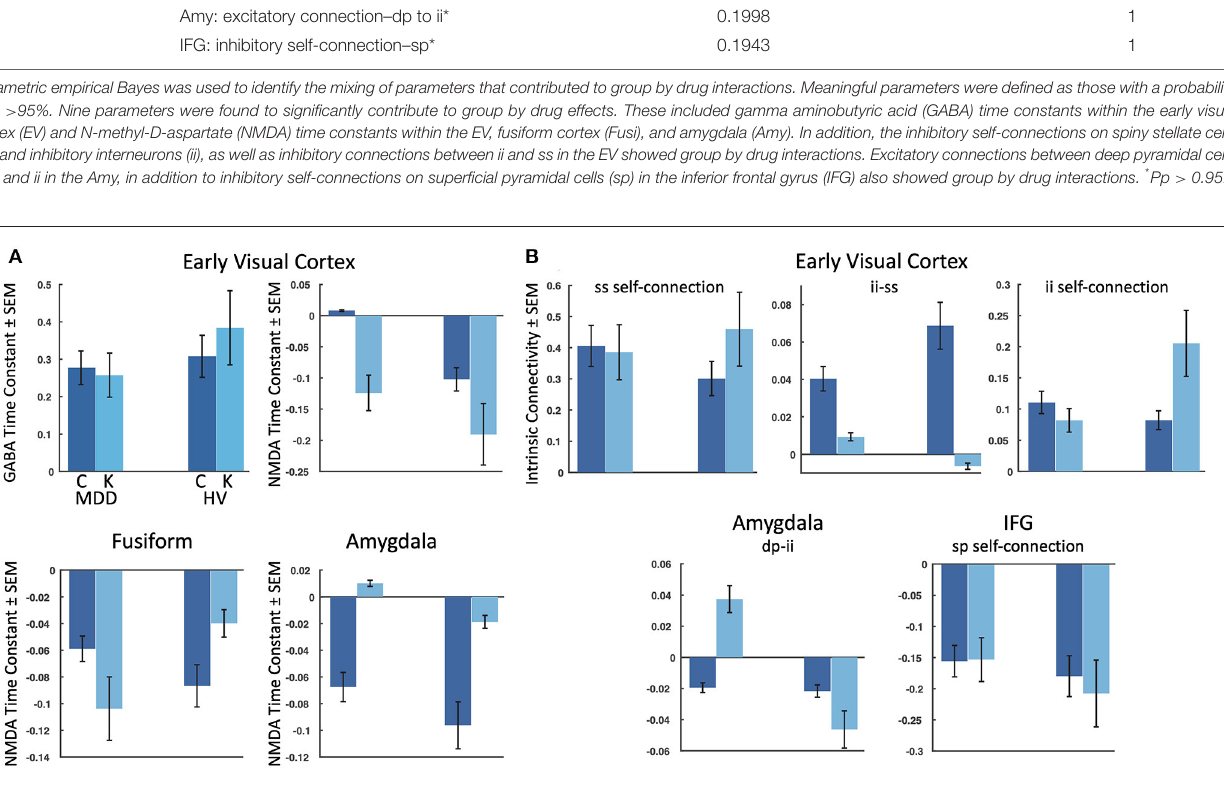
FIGURE 3 | Meaningful parameters showing group by drug interactions. The estimated log mean and variance of each meaningful (95% probability or greater) parameter are plotted for participants with treatment-resistant major depressive disorder (MDD) (left) and healthy volunteers (HV) (right) for: (A) the four receptor time constants showing group by drug interactions, and (B) the five intrinsic connectivity parameters showing group by drug interactions. IFG, inferior frontal gyrus, C, baseline/placebo sessions, K, ketamine session, ss, spiny stellate cells; ii, inhibitory interneurons; sp, superficial pyramidal cells; dp, deep pyramidal